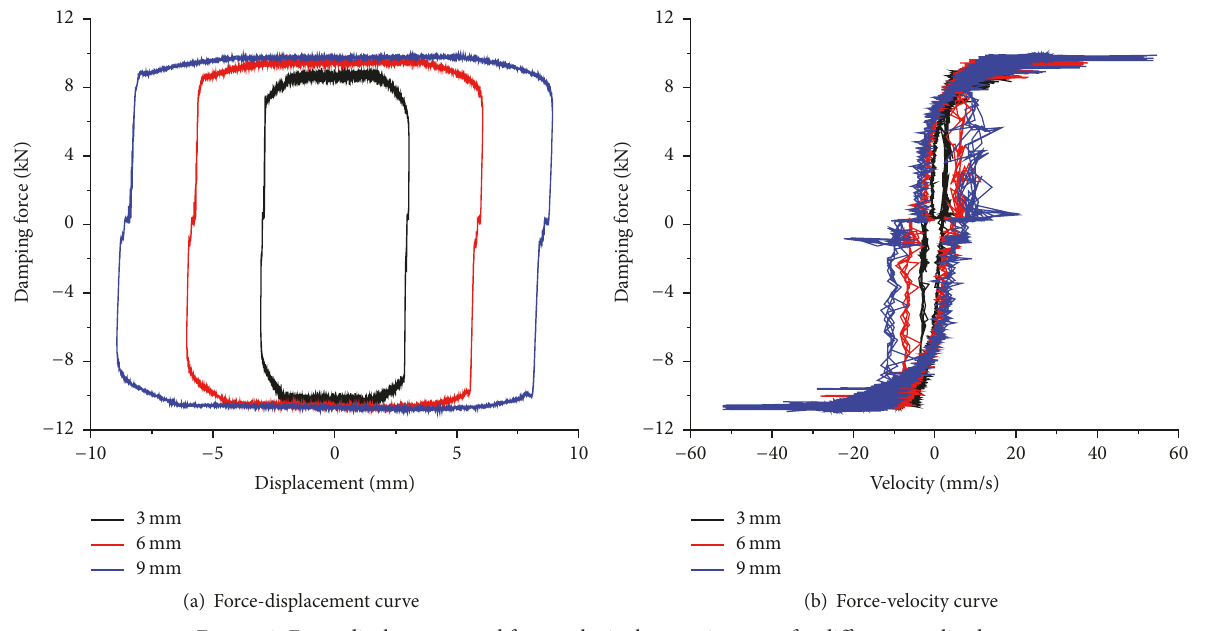
Figure 2: Force-displacement and force-velocity hysteresis curves for different currents.